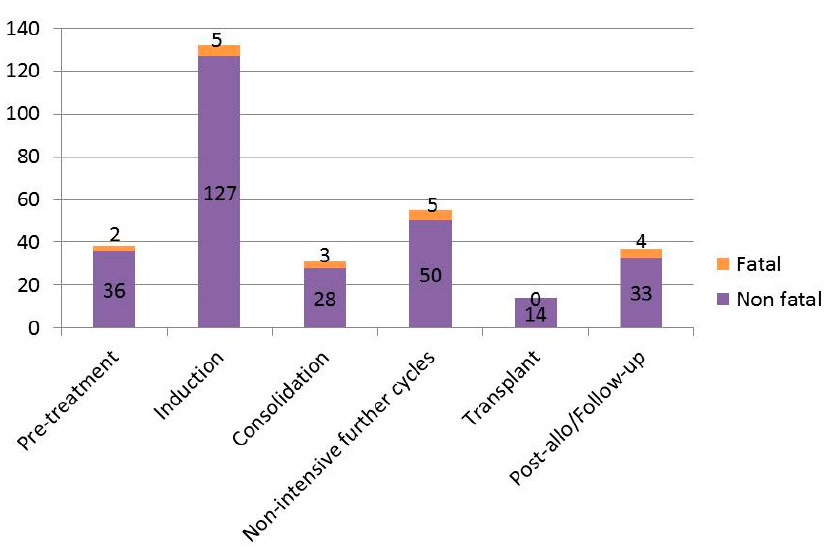
Figure 2. Timing of cardiac events in the overall